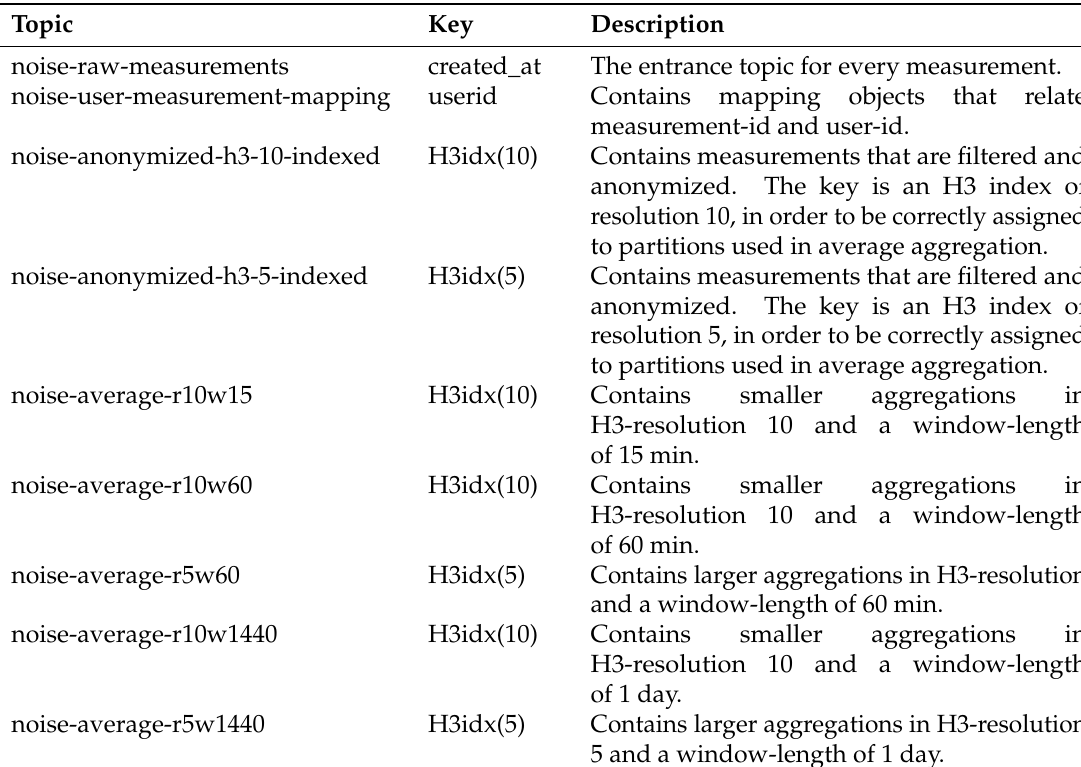
Table 2. Kafka topics used in the noise measurement stream